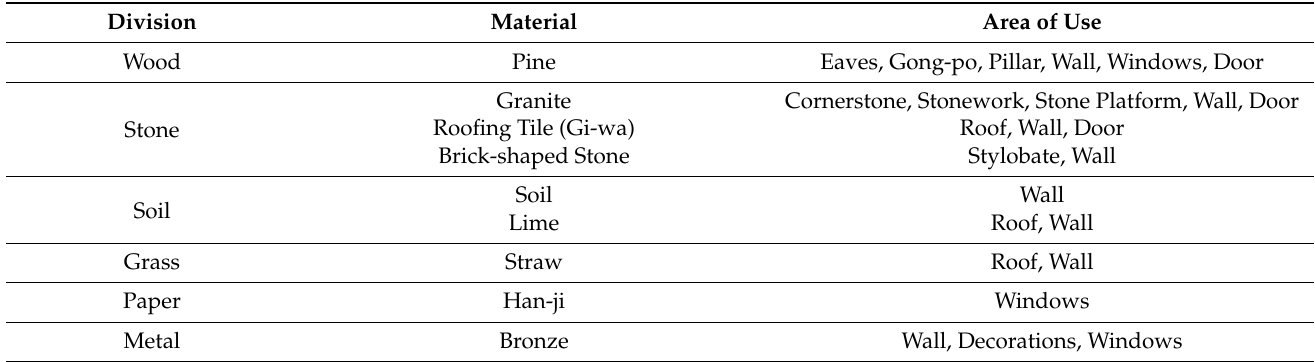
Table 1. Materials and structure of the hanok